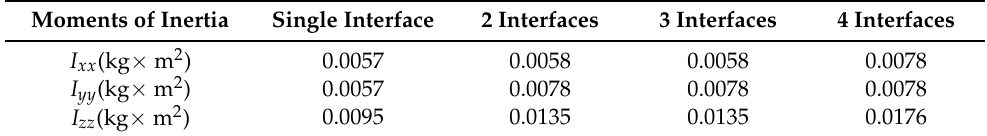
Table 1. Moments of inertia according to the number of additional